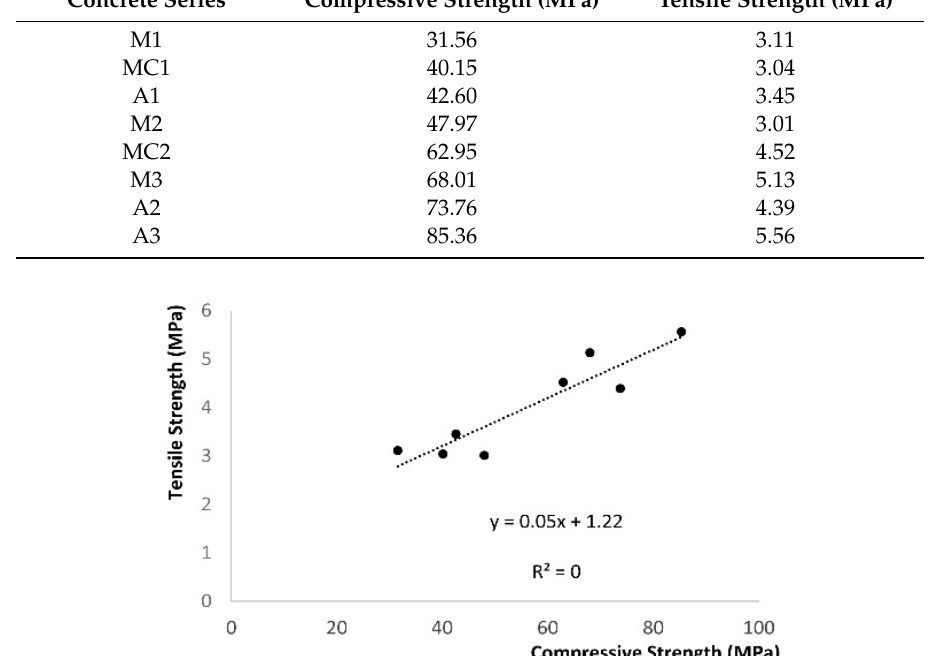
Figure 4. Experimental setup for induced tensile load capacity in a concrete sample. Table 6. Average compressive and tensile strengths for di ff erent concrete series.